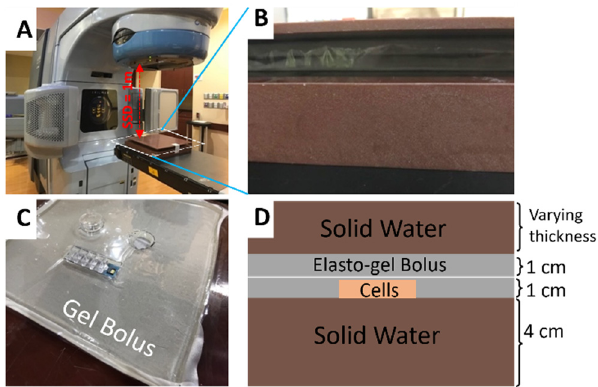
Figure 1. ( A ) Experimental in vitro cell irradiation on LINAC. ( B ) Bolus between solid water backscatter and solid water build-up from side view. ( C ) Circular cell cutouts within elasto-gel bolus. ( D ) Diagram showing cells, bolus and solid water used for in vitro cell irradiations.